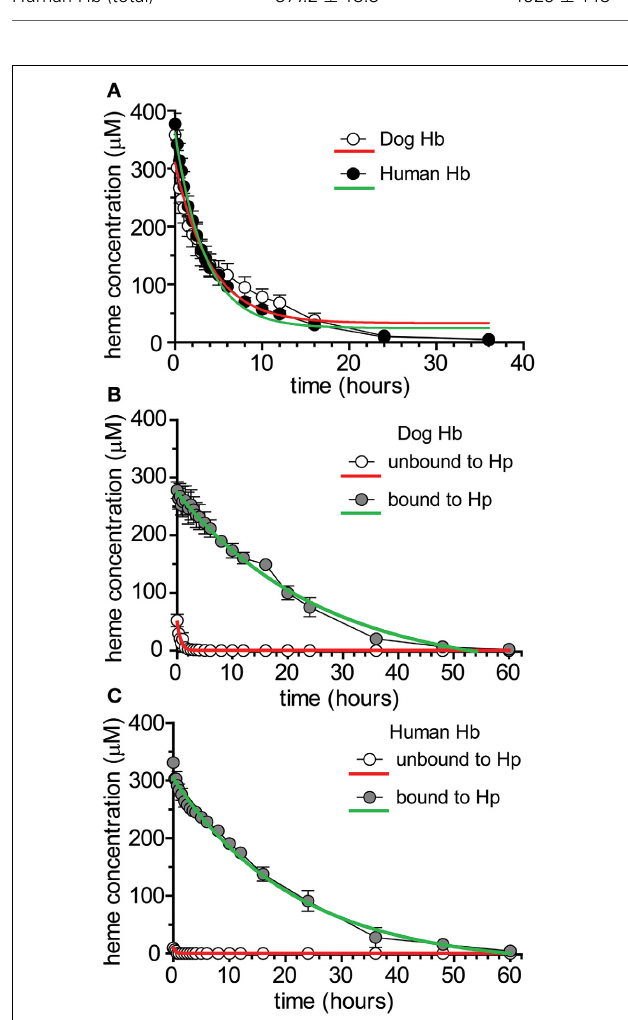
FIGURE 3 | Pharmacokinetics of dog and human Hb ± glucocorticoid up-regulation of Hb clearance systems. (A) Mean ± SEM plasma concentration vs. time plotted for dog and human purified Hb administered to beagle dogs ( n = 4/treatment). Data are fitted to a single exponential decay (red and green traces) and represent total heme bound to Hb + Hb:Hp. Pharmacokinetic parameter estimates are shown in Table 1 . (B) Mean ± SEM plasma concentration vs. time plotted for prednisone pre-treated Beagle dogs administered purified dog Hb ( n = 6). Data represent unbound and Hp bound concentrations in plasma. Data are fitted to a single exponential decay and represent total heme bound to Hb + Hb:Hp. Pharmacokinetic parameter estimates are shown in Table 2 . (C) Mean ± SEM plasma concentration vs. time plotted for prednisone pretreated Beagle dogs administered purified human Hb ( n = 6). Data represent unbound and Hp bound concentrations in plasma. Data are fitted to a single exponential decay (red and green traces) and represent total heme bound to Hb + Hb:Hp. Pharmacokinetic parameter estimates are shown in Table 2